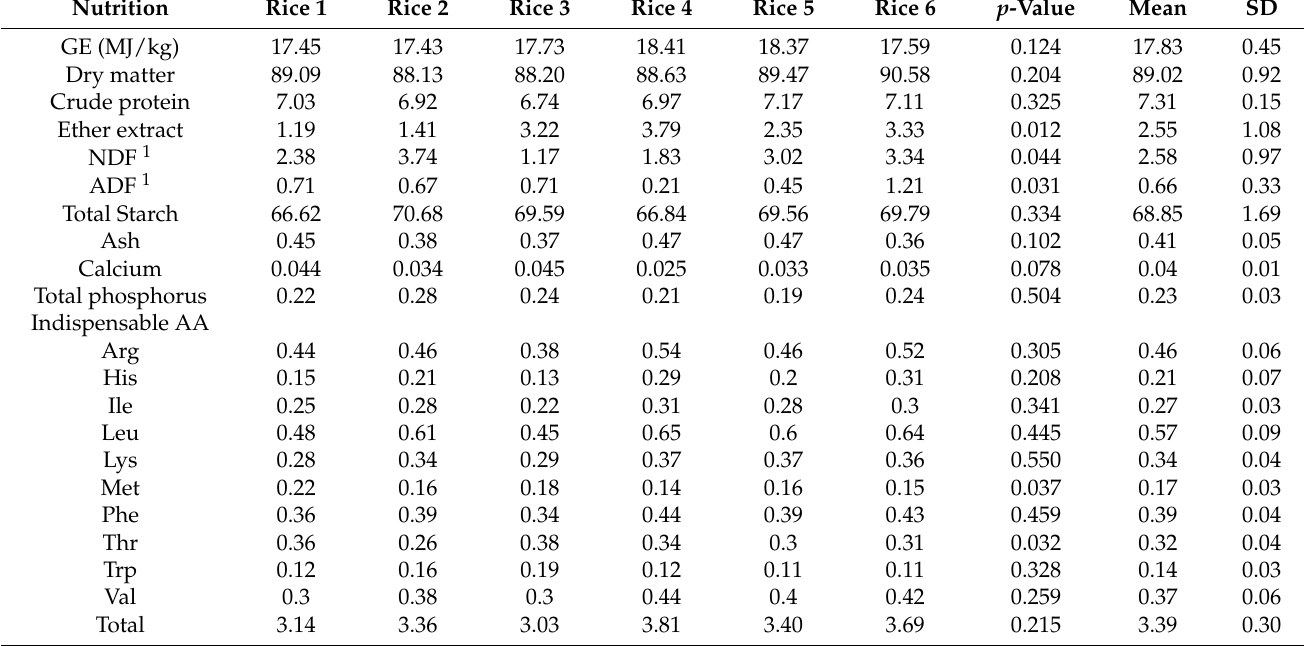
Table 2. Analyzed nutrition and amino acid composition of different sources rice